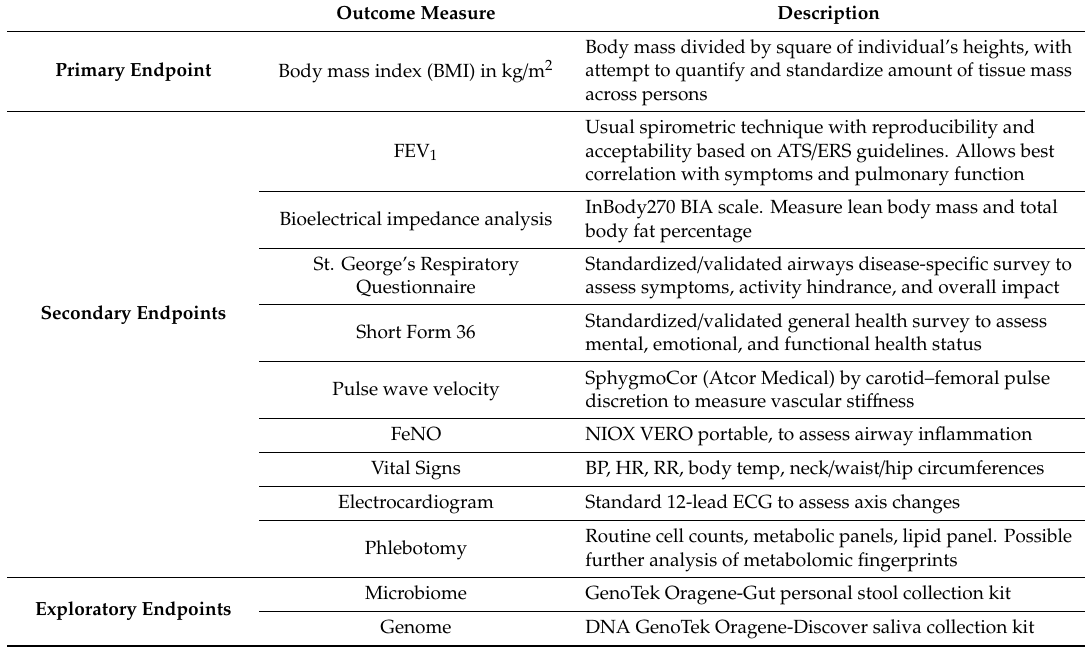
Table 4. Endpoints of the FIREHOUSE